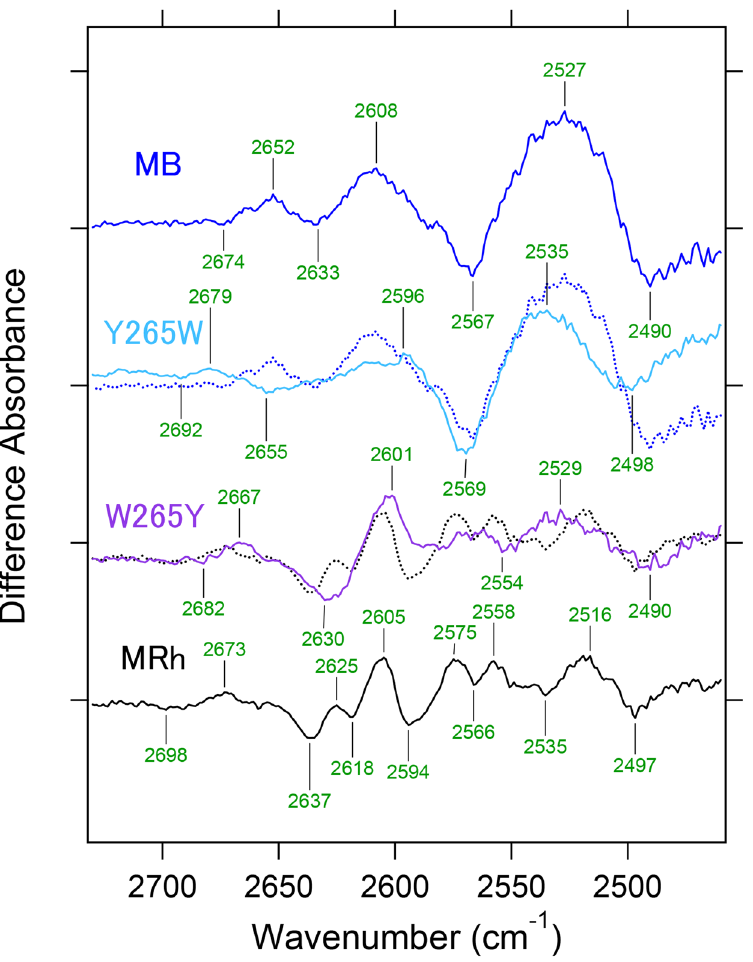
Figure 5. Spectral comparison of the mutant protein in the 2730–2460 cm − 1 region at 77 K. Light-induced all- trans minus 11- cis difference FTIR spectra of MB, MB-Y265W, MRh-W265Y and MRh in the 2730–2460 cm − 1 region measured at 77 K in D 2 O. Blue and black dotted lines correspond to MB and MRh, respectively. One division of the y-axis corresponds to 0.00016 absorbance